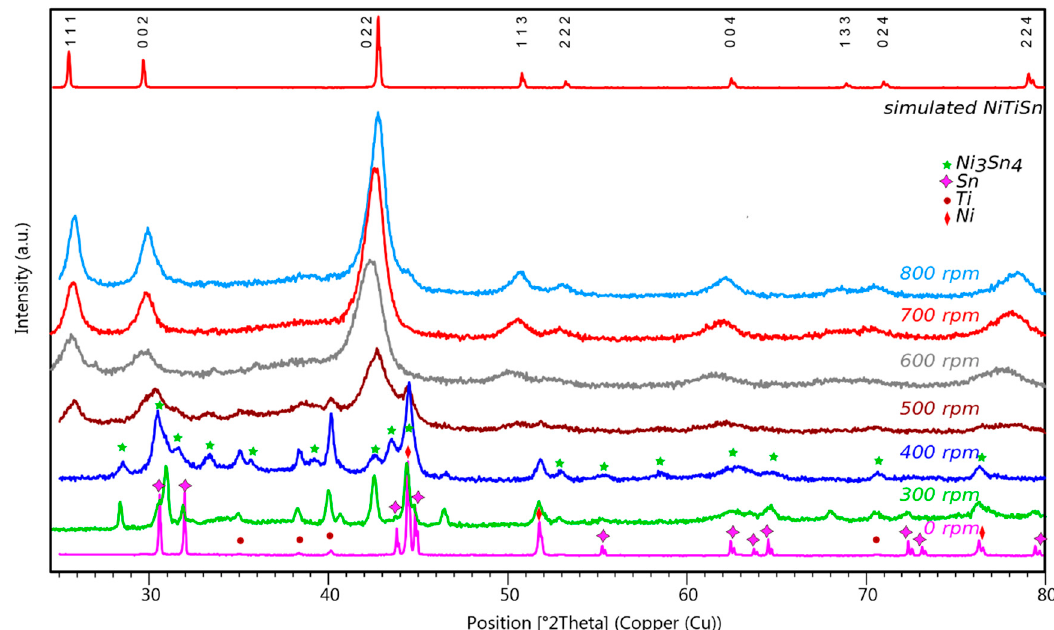
Figure 2. XRD patterns for samples prepared by MA during 5 h. Energy provided to samples varies with rotation speed taken from 300 to 800 rpm. The pattern for the stoichiometric Ni:Ti:Sn mixture before MA is drawn at the bottom, and the simulated pattern for the cubic NiTiSn half-Heusler compound at the top.